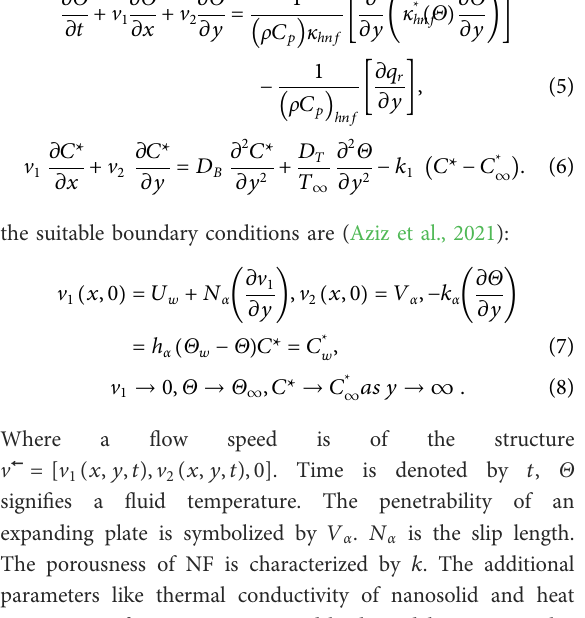
FIGURE 1 Flow model illustration.